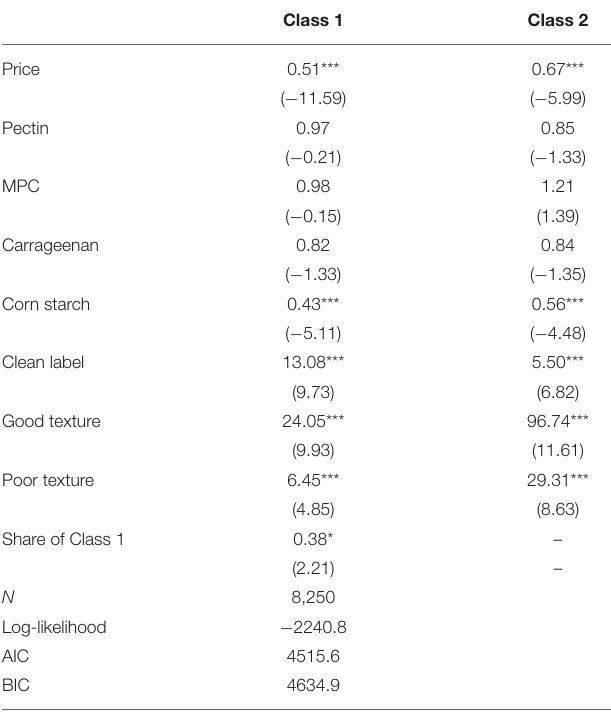
TABLE 5 | Latent class conditional logit model, two classes, alternative specific fixed effects, robust clustered errors.